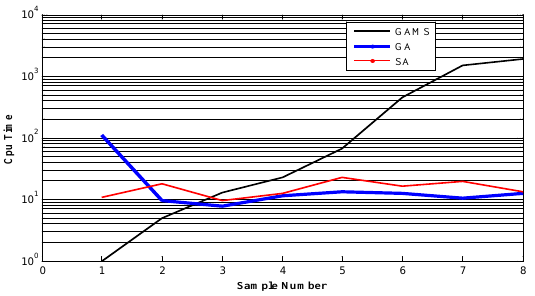
Fig. 5. Comparison of computational time of the GA and SA in medium problems